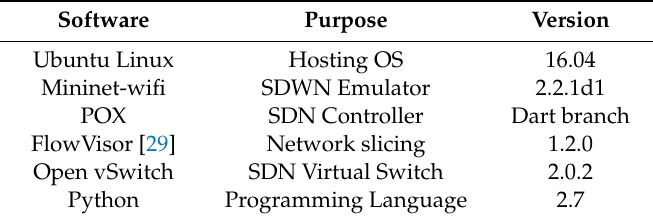
Table 1. Software used in experiment.